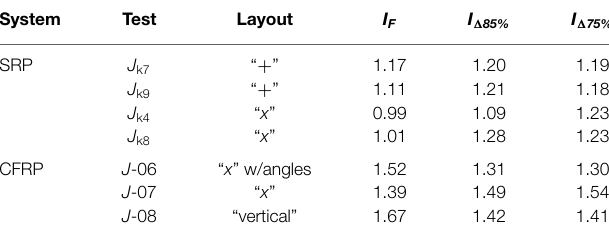
TABLE 3 | Indices of strength and